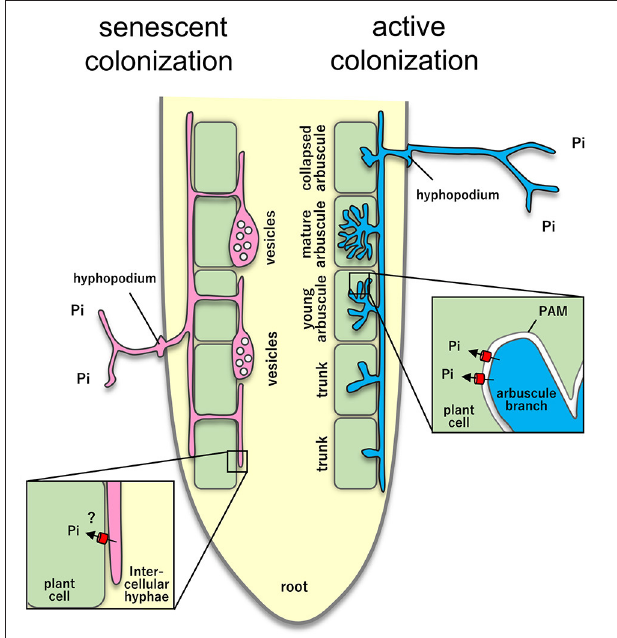
FIGURE 1 | Lifecycle of intraradical colonization and the expression of phosphate transporter in arbuscular mycorrhizal symbiosis. A colonized region derived from one AMF hypha is called “infection unit.” Hyphae penetrate root epidermis and extends into the intercellular space ( Arum -type) or intracellularly ( Paris -type; not shown) in cortical cells. In these processes, arbuscules that are involved in nutrient exchange are formed in cortical cells in order from the initial penetration site (hyphopodium). Therefore, the arbuscules that are closest to the penetration site are the oldest, and the arbuscule close to the tip of the growing hyphae is the newest. Since the arbuscules have short lifespan (1–2 days), they collapse in order from the oldest one. Arbuscules are surrounded by plant membrane (periarbuscular membrane). Plant phosphate transporter proteins are localized on this membrane and are responsible for the uptake of phosphate from the arbuscules. In the senescent colonization stages of infection unit, vesicles and intercellular hyphae are often observed. The role of these intraradical AMF structures is still